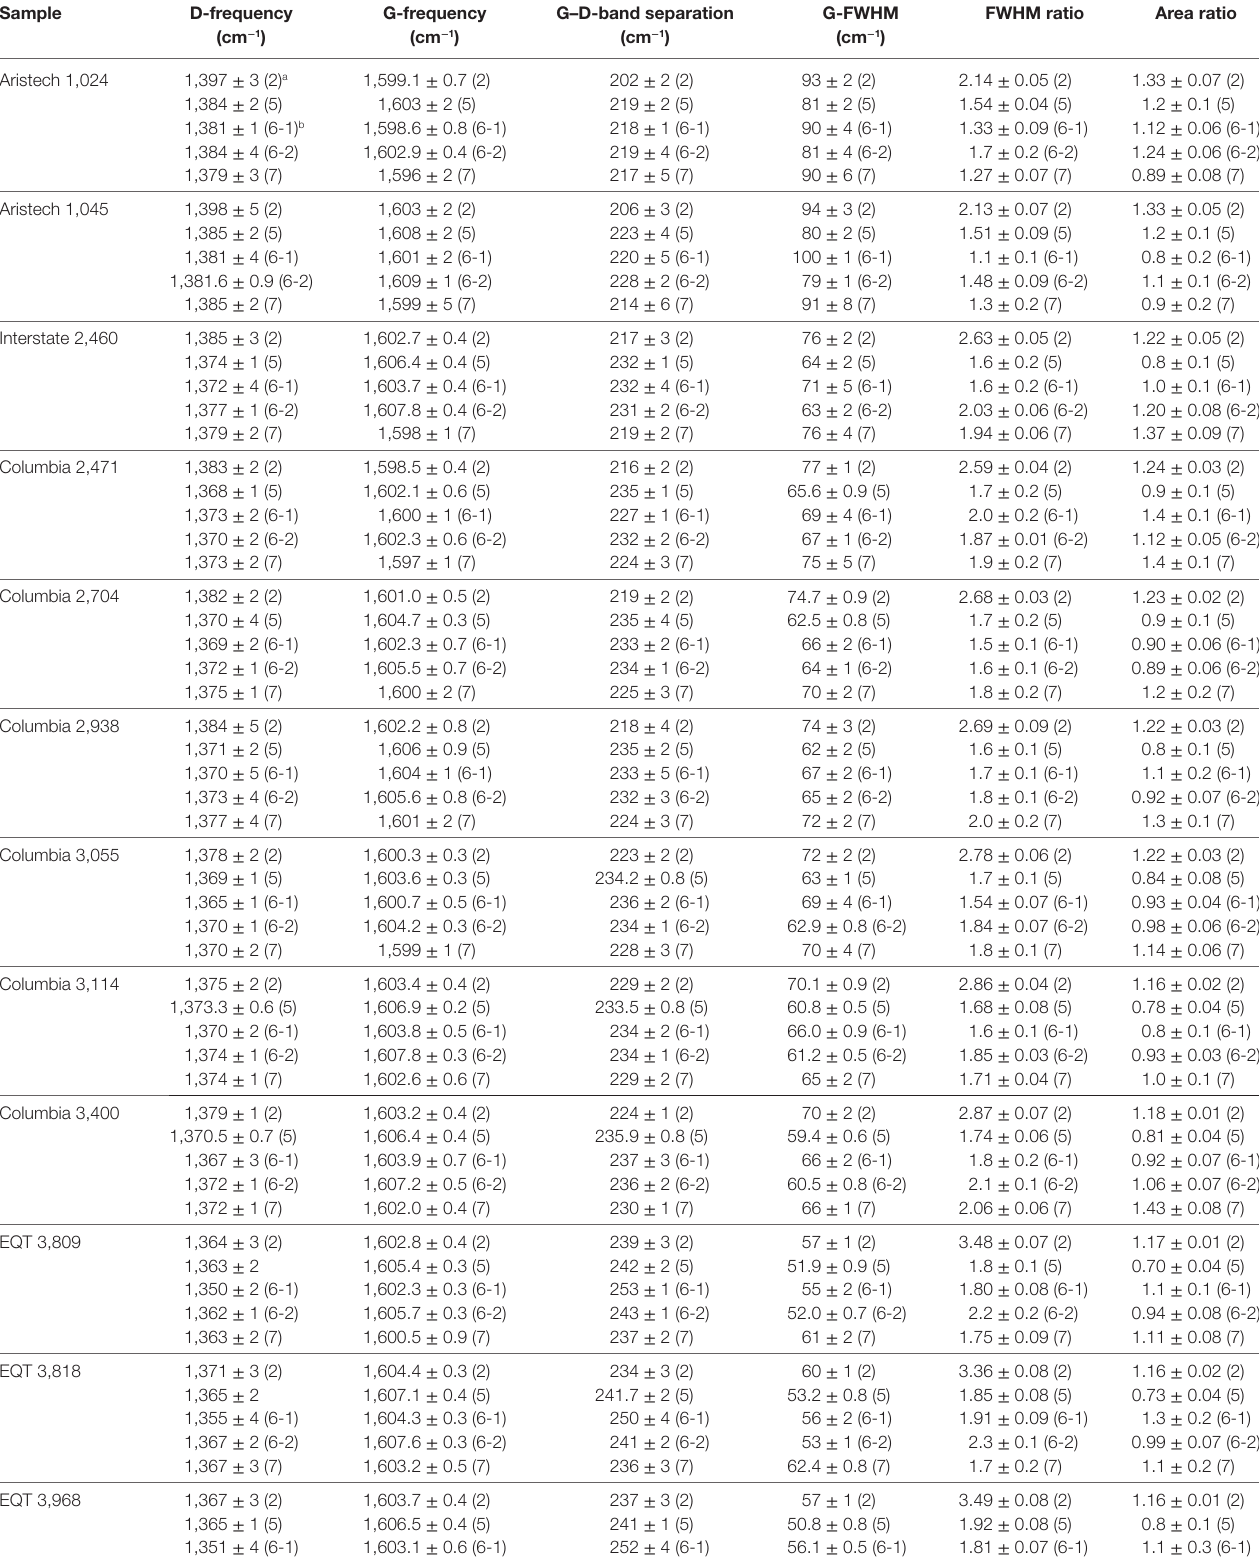
Table 2 | Mean Raman spectral peak-fit parameters from five averaged spectra obtained using a 200 cm − 1 maximum peak width.